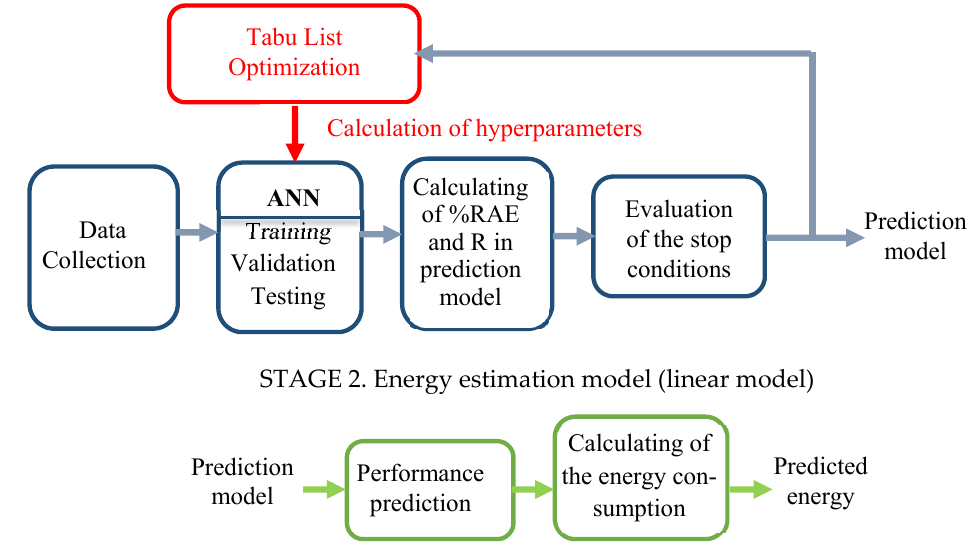
Figure 3. Prediction of the energy consumption of a robot in an exploration task using an optimized neural network. Table 1. Characteristics of the datasets used for training, validation and